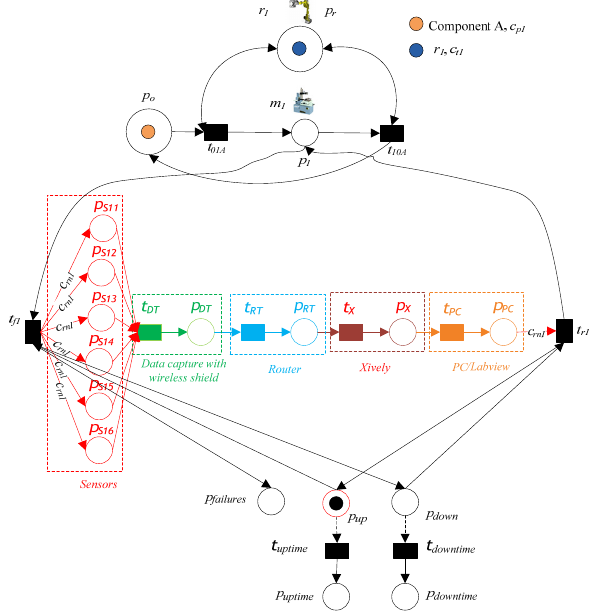
Figure 5. Reliability design of the net illustrated in Figure 4.